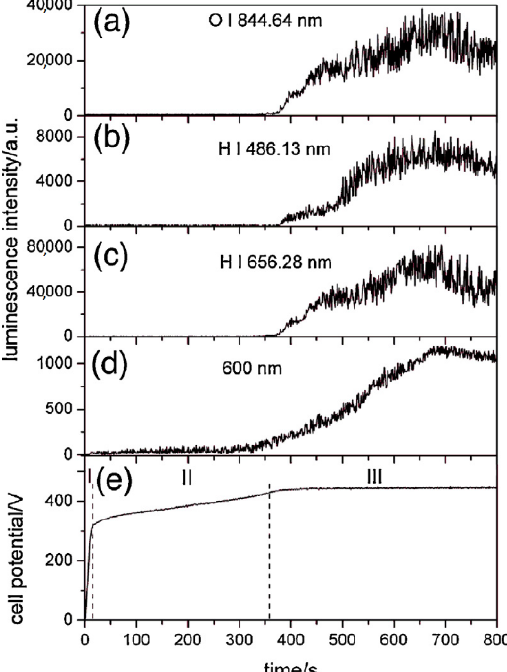
Figure 4. The temporal variation in the luminescence intensity of ( a ) oxygen and ( b , c ) hydrogen lines, ( d ) continuum radiation at 600 nm, and ( e ) cell potential. Adapted with permission from Ref. [61]. Copyright 2015 Elsevier.